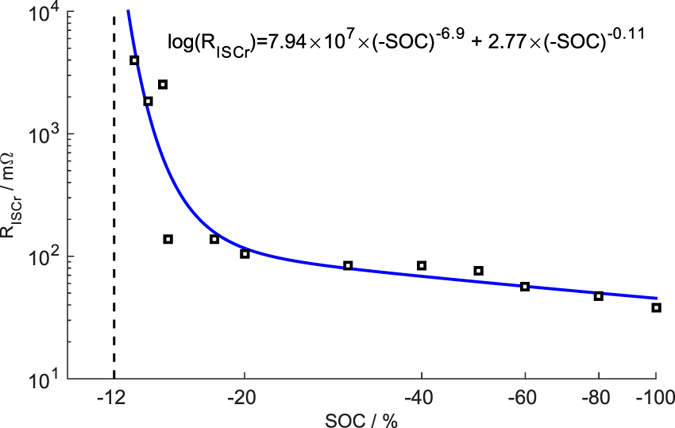
The relationship between RISCr and terminal SOC.